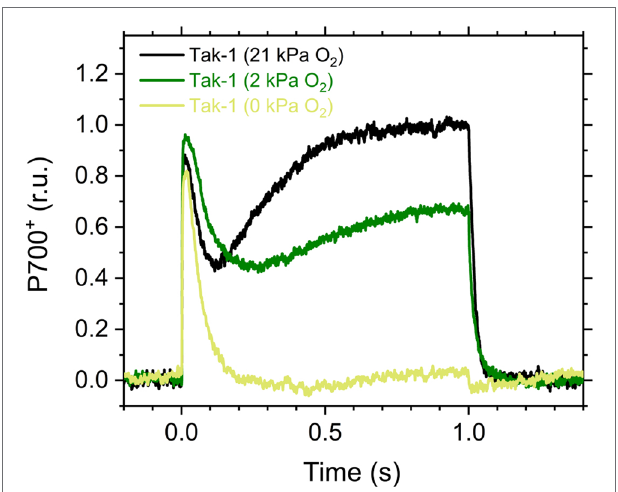
FIGURE 1 | Kinetics of oxidized P700 (P700 + ) in the illumination with a short- pulse light (2,000 μ mol photons m − 2 s − 1 , 1 s) in the liverwort Marchantia polymorpha (Tak-1). Experiments were performed under 21 (black), 2 (green), and 0 kPa O 2 (light green). Relative P700 + signals are normalized by the maximum oxidation level of P700 as 1.0. Representative traces of the three independent measurements are shown, respectively.